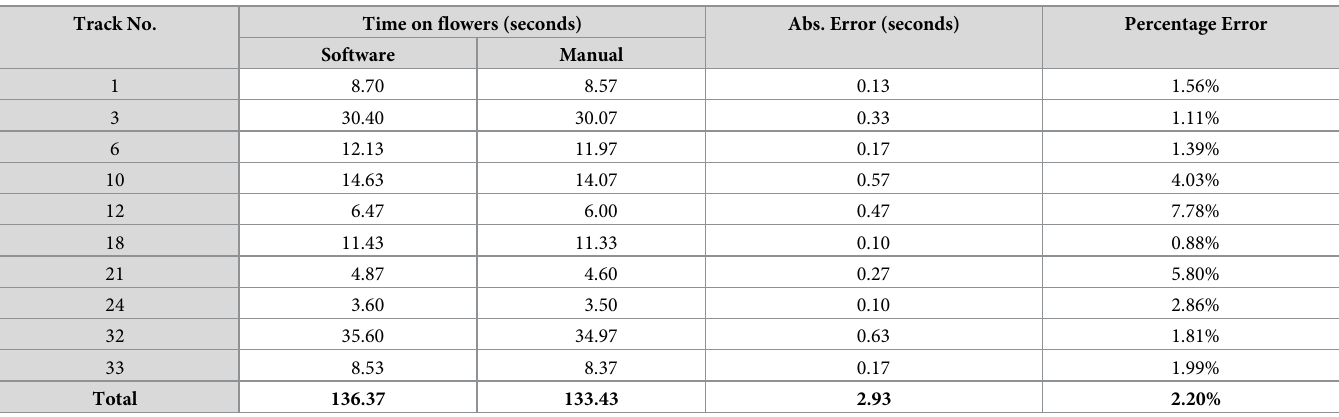
Track No . is the number (occurrence sequence) of the recorded honeybee track, Time on flowers is the total duration a honeybee spends on strawberry flowers measured using the software and observed from the video manually.